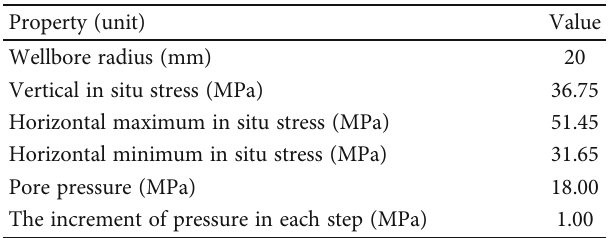
Figure 6: Schematic of horizontal wellbore in formation. Table 2: In situ stress and injection